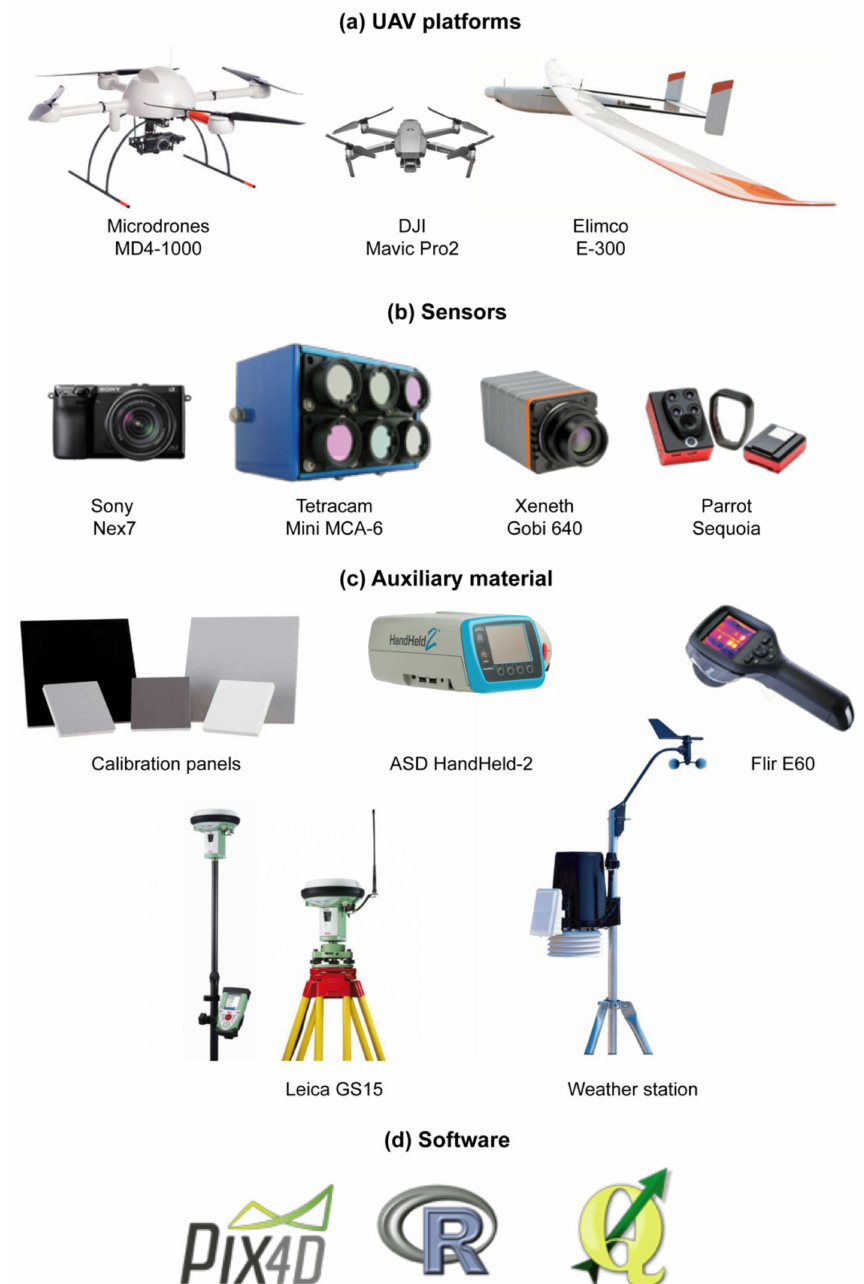
Figure 3. Materials provided to students: ( a ) UAV platforms, ( b ) sensors, ( c ) auxiliary materials and ( d )